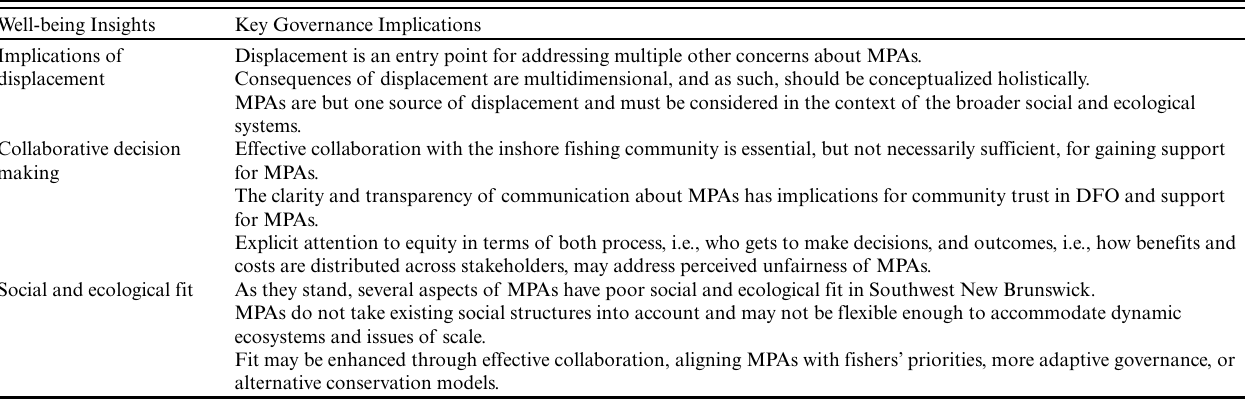
Table 5 . Key implications for marine protected area (MPA) governance from social-ecological well-being insights. DFO, Fisheries and Oceans